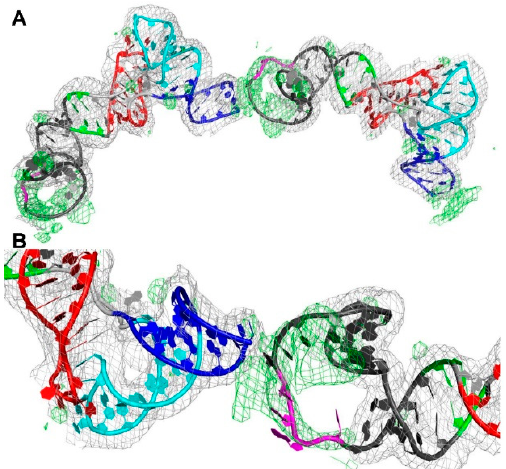
Figure 6. The 6.1 Å resolution maps and preliminary model for the tRNA acceptor–T-box antitermi- nator interaction in space group P 6 1 22. ( A ) Overall structure of the complex formed through crystal symmetry and ( B ) close-up of the trapped tRNA UCCA–antiterminator interaction. The structure was solved by molecular replacement with core tRNA scaffold and the terminal GAAA-tetraloop. After a round of rigid body refinement, omit 2 F o -F c (grey, contoured at 1.0 σ ) and F o -F c (green, contoured at 2.5 σ ) maps are shown as mesh. The complete model was placed in the density by fusing the 2.95 Å resolution Construct #4 structure antiterminator in the molecular replacement model. The unmodelled region is drawn with bases removed in part A.